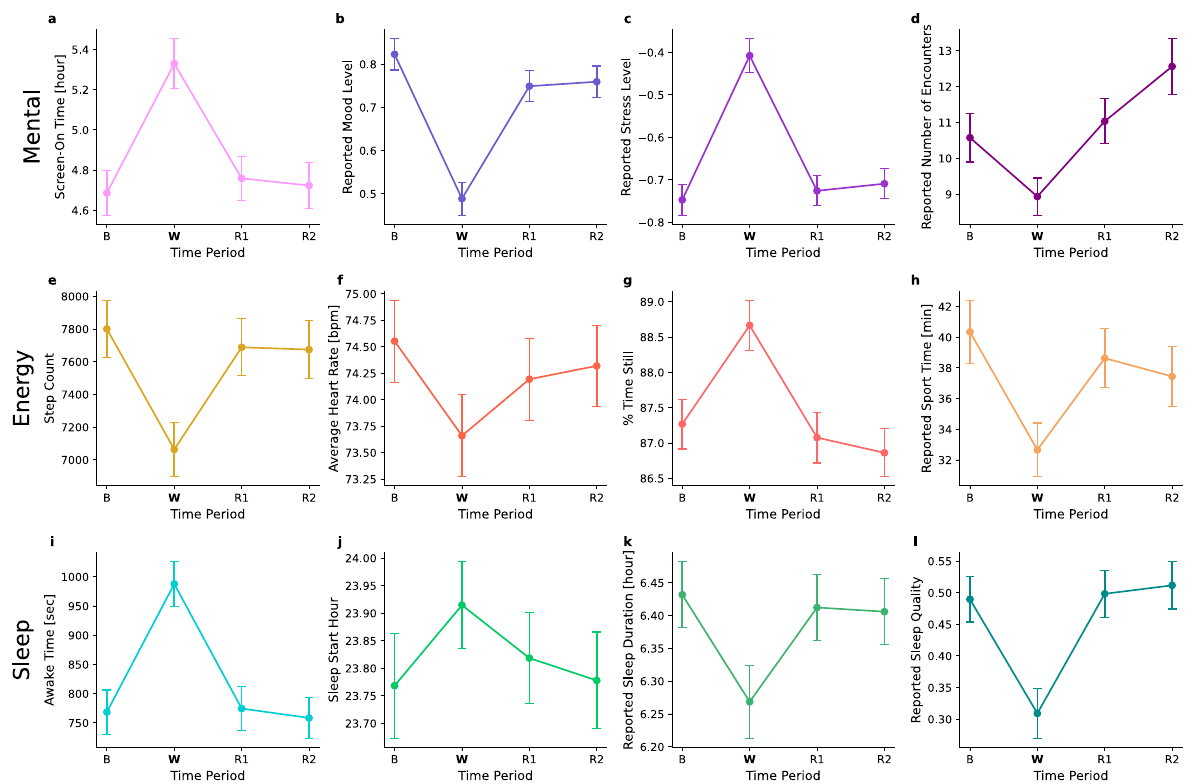
Fig. 2 Effects of the war on the entire population for various wellbeing indicators. The presented well-being indicators include a Screen-on time in hours, b Reported mood level, c Reported stress level, d Reported number of encounters, e Step count, f Average heart rate in beats per minute, g Percentage of time still, h Reported sport time in minutes, i Awake time during night sleep in seconds, j Sleep start hour, k Reported sleep duration in hours, and l Reported sleep quality. The x-axis represents four time periods: baseline period (B), war period (W), fi rst “ back to routine ” period (R1), and second “ back to routine ” period (R2). The y-axis represents the mean value for the examined well-being indicator. Error bars represent a single standard